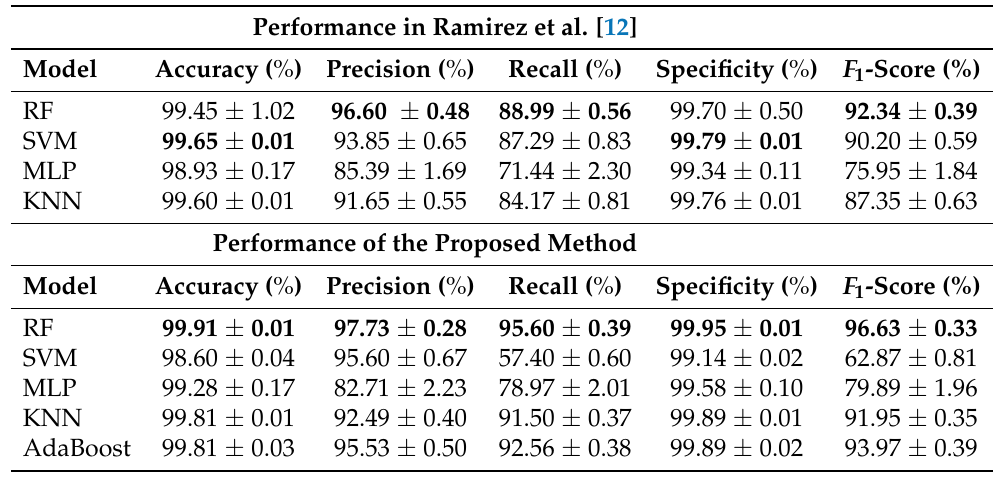
Table 5. Performance (mean ± standard deviation) obtained for each model of the activity recognition system using